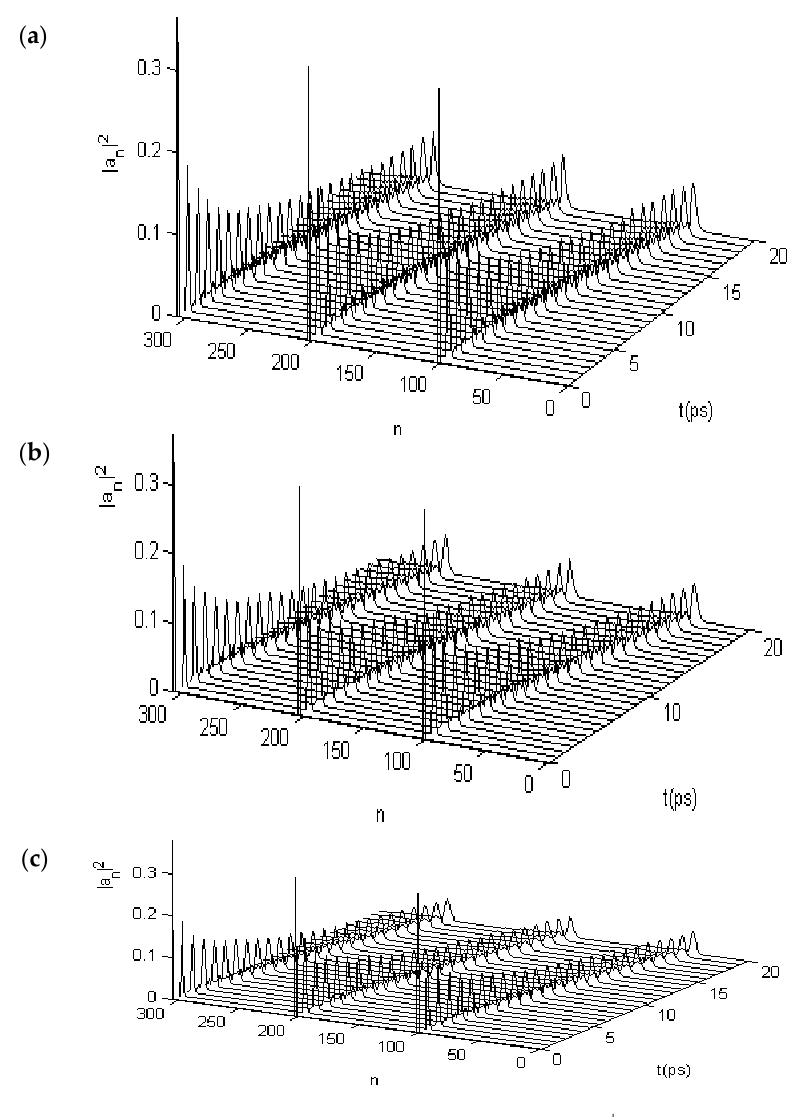
Figure 6. States of solitons in α -helix protein molecules of which E = ( a ) 17,000; ( b ) 25,500; and ( c ) 34,000 V/m, respectively.